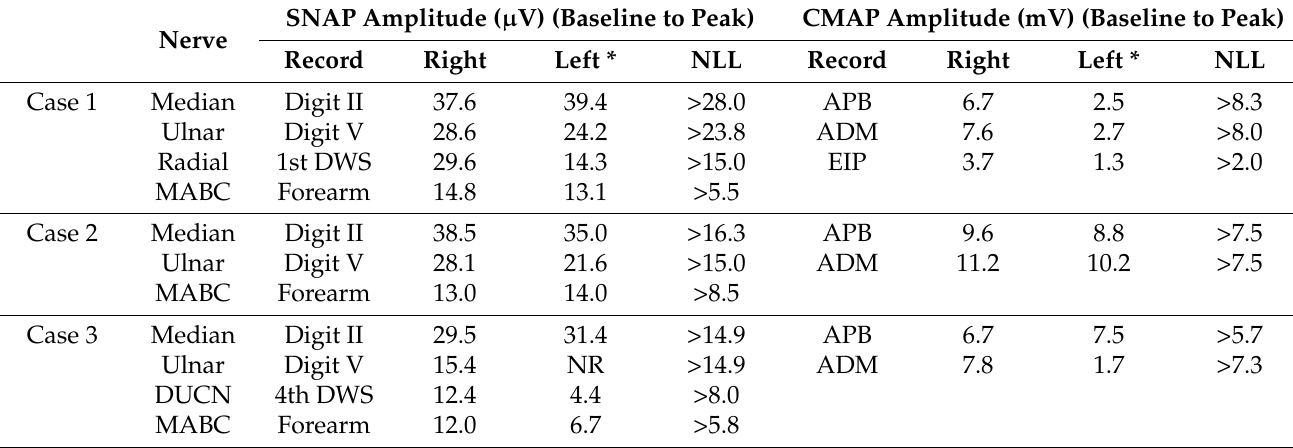
Table 1. Results of sensory/motor nerve conduction